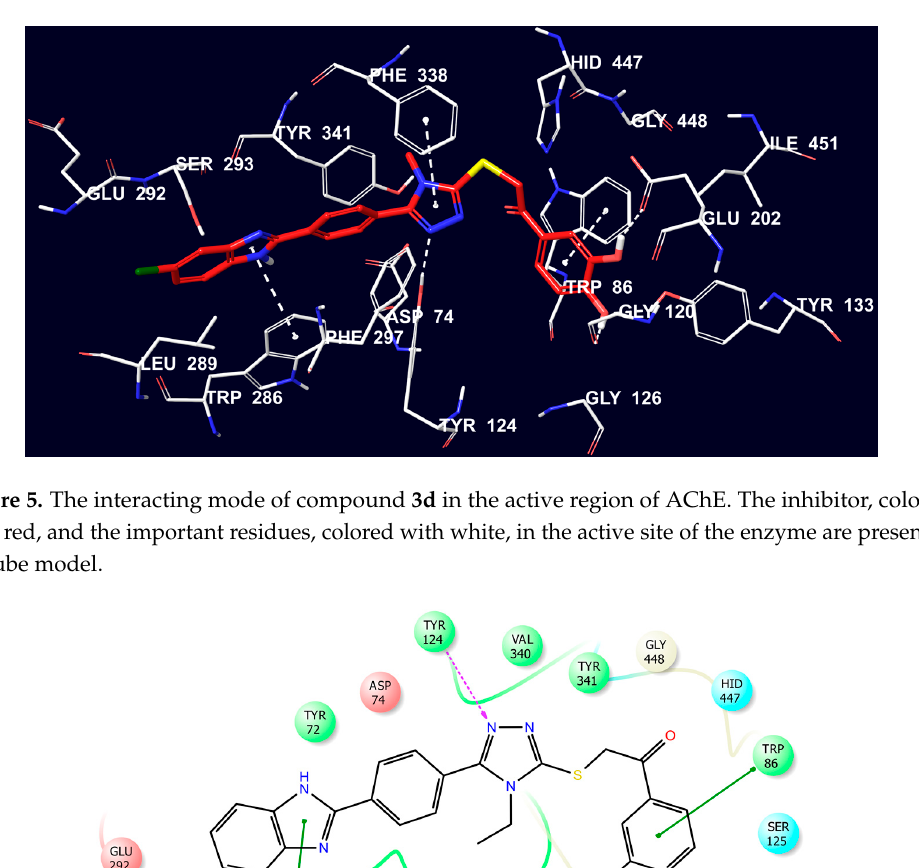
Figure 4. Two-dimensional interaction mode of compound 3d in the enzyme active site of AChE.